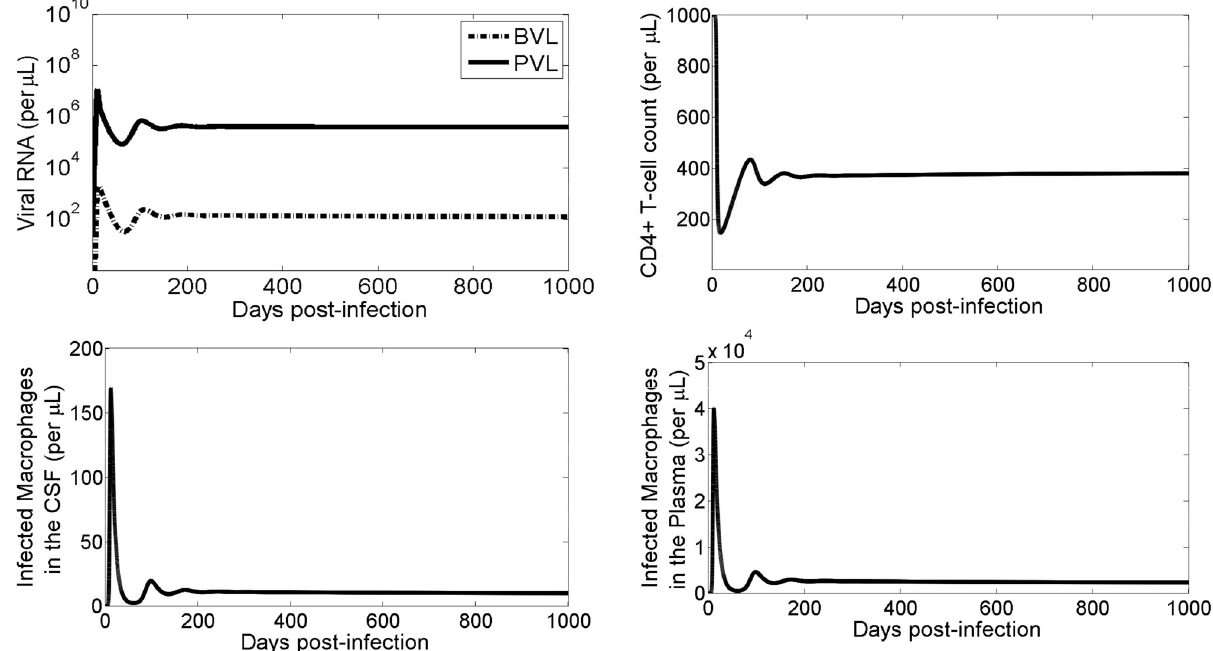
Fig 6. Long-term model simulations. Viral load (top left) for the plasma (solid line) and the brain (dashed line) along with the CD4+ T cell count (top right) and the total infected macrophages (bottom row) in the brain (bottom left) and in the plasma (bottom right).